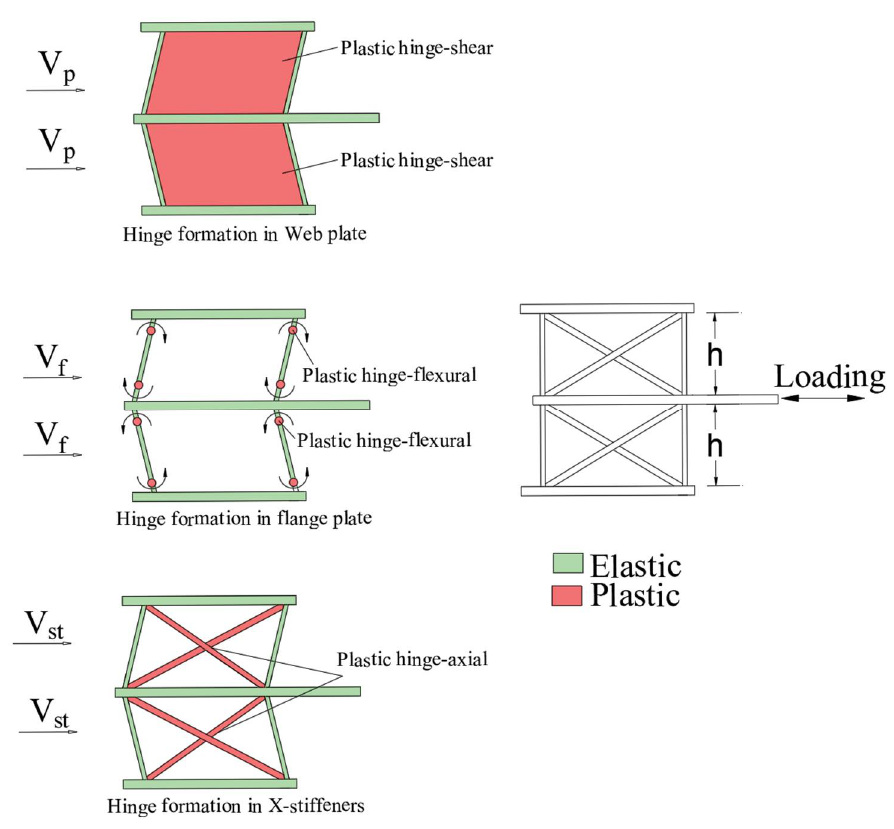
Figure 2. Expected hinge formation over proposed damper.